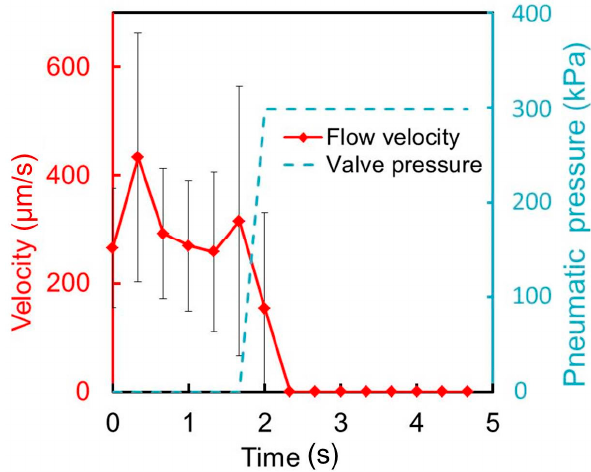
Figure 15. Time variations of the mean cell velocity and pressure applied to the pneumatic microchannel for the microvalve with a liquid microchannel height of 100 μ m ( n = 9).